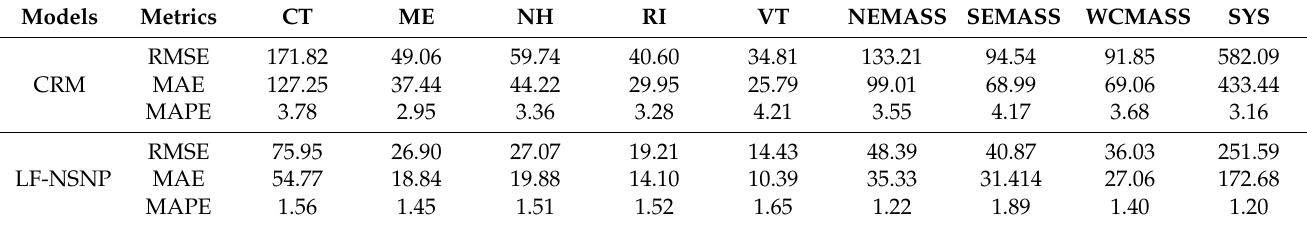
Table 1. Performance comparison between the exploited LF-NSNP model and CRM model for case study